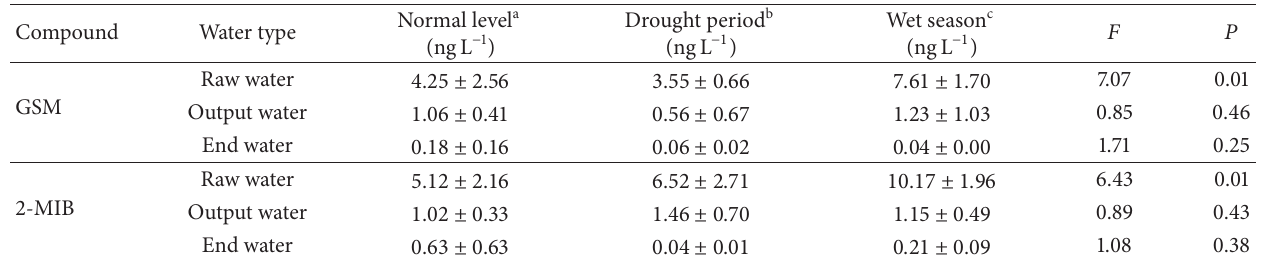
Table 4: Water samples from different seasons ( 𝑛 = 45